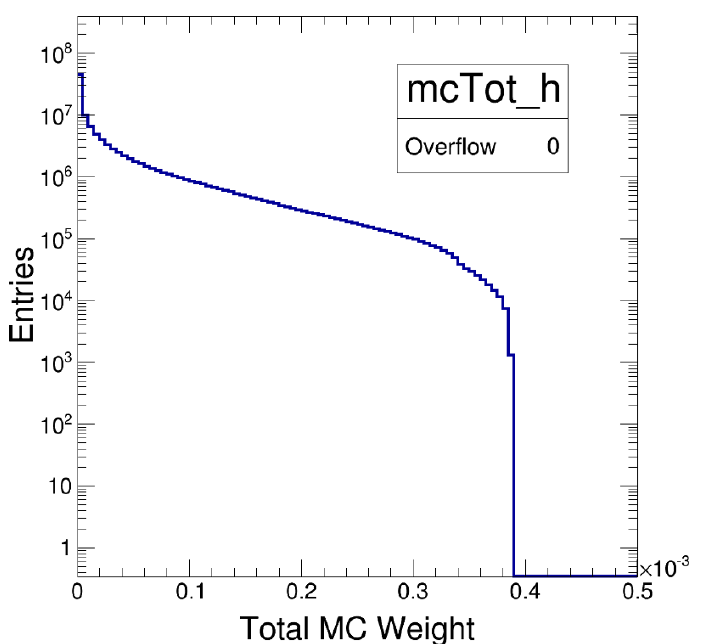
Figure 6 . An example of mcTot h (pp energy 13 TeV, E Sph = 9 TeV) that has a high enough maximum weight for the sample